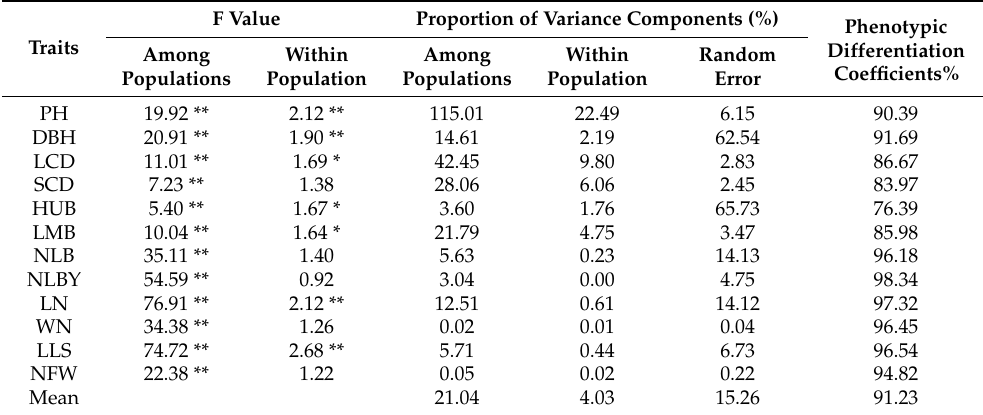
Table 2. Variance analysis and phenotypic differentiation coefficients among the P. yunnanensis populations sampled.